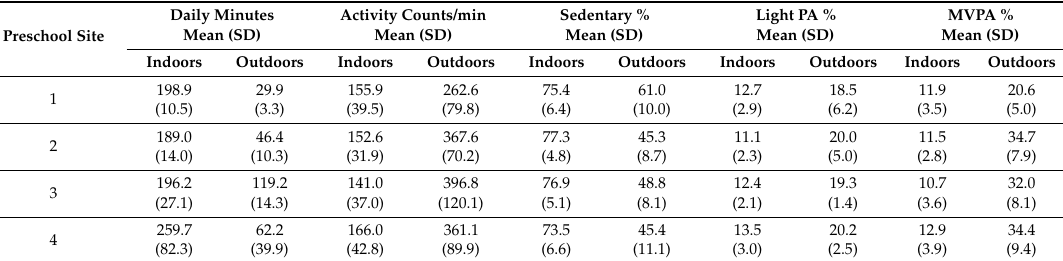
Table 2. Physical activity by indoor and outdoor